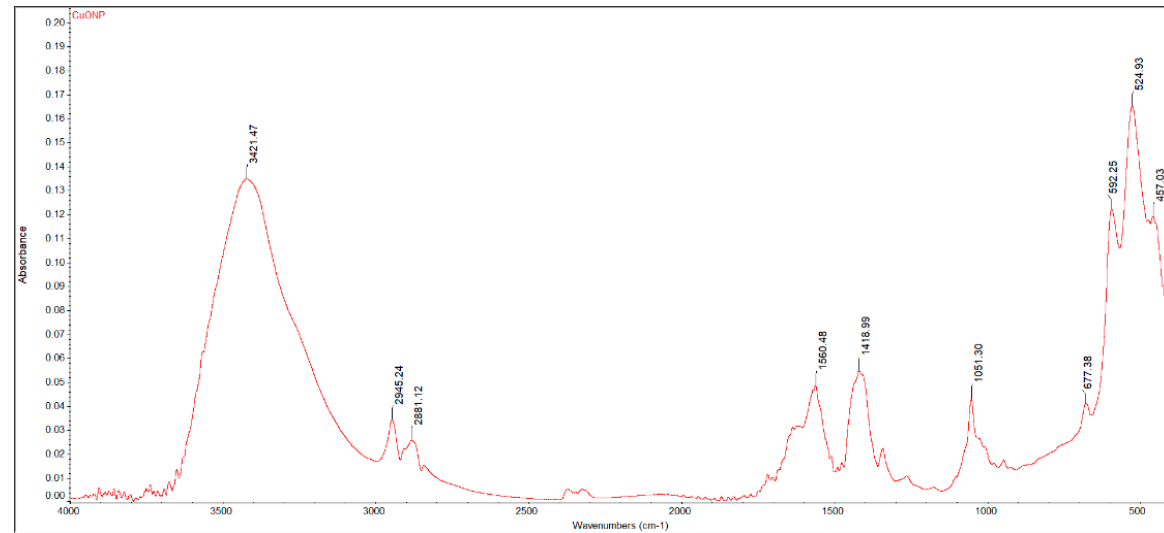
Figure 1. FTIR spectrum of the CuONP material.